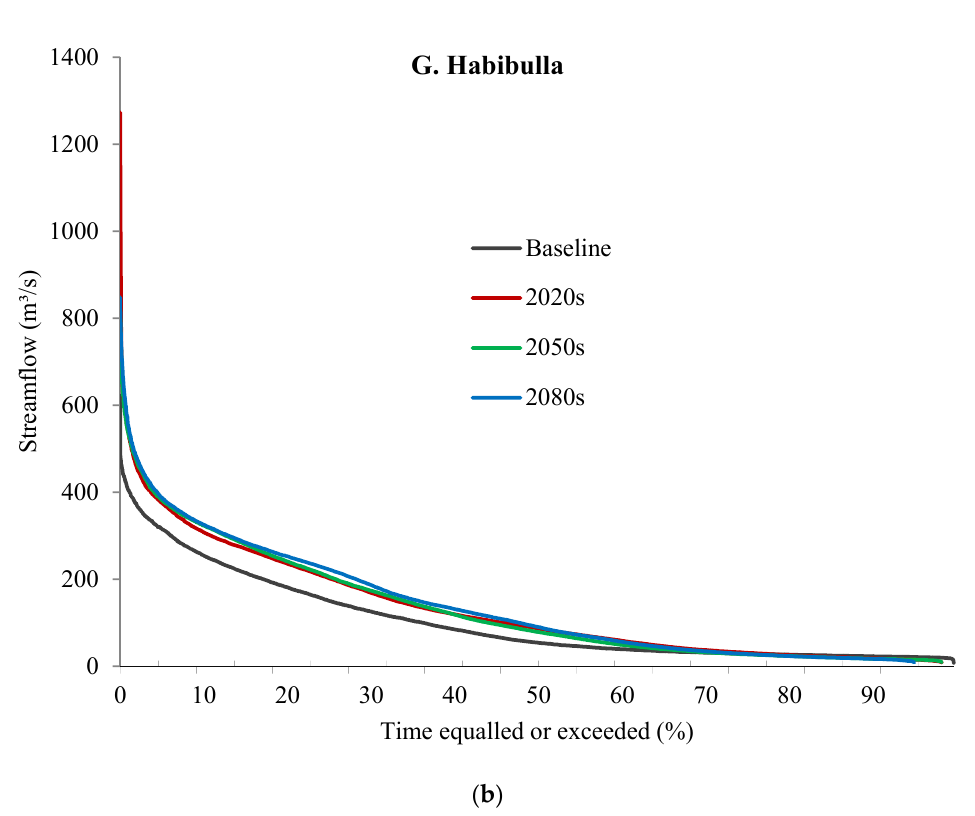
Figure 8. Flow duration curves under ( a ) A2 and ( b ) B2 scenarios at Gari Habibullah in the Kunhar River basin. Table 5. Percent future changes in low, median, and high flows with respect to the baseline (1961–1990) under A2 and B2 scenarios in the Kunhar River basin.